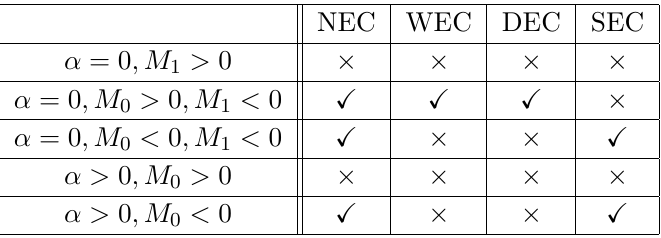
Table 1 . The energy conditions near r = 0 in the spacetime (2.6) with eq.